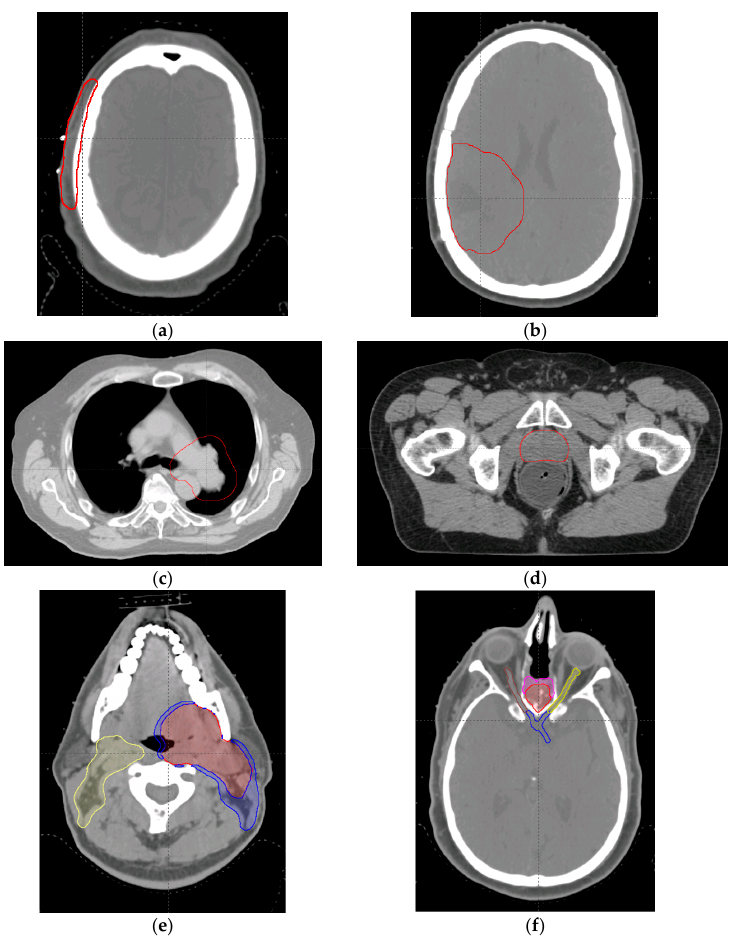
Figure 6. Representative target volumes in the transverse plains for the cases in this study. ( a ) scalp case; ( b ) brain case; ( c ) lung case; ( d ) prostate case; ( e ) H & N case; and ( f ) BOS case. For ( a – d ), the red contour is the clinical target volume (CTV). For ( e ), the red, blue, and yellow contours are CTV1, CTV2, and CTV3, respectively. For ( f ), the red and magenta contours are CTV1 and CTV2, respectively; and the yellow, brown, and blue contours are the left optic nerve, right optic nerve, and optic chiasm, respectively. Table 5. Treatment planning information for the cases selected for this study.